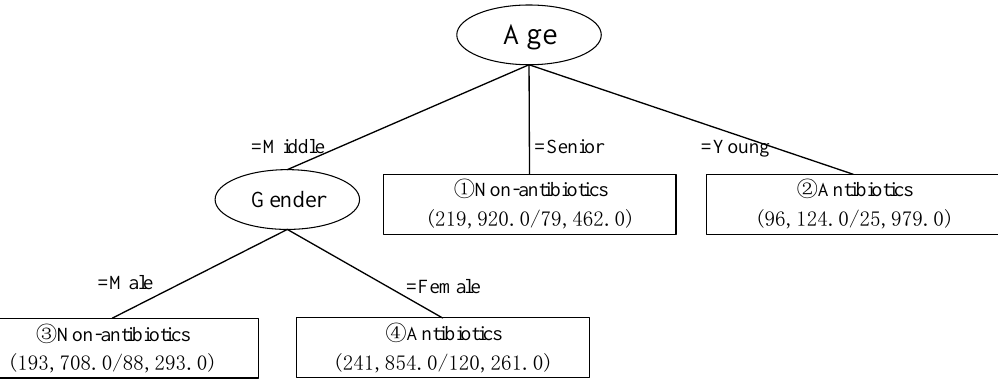
Figure 3. Decision tree.